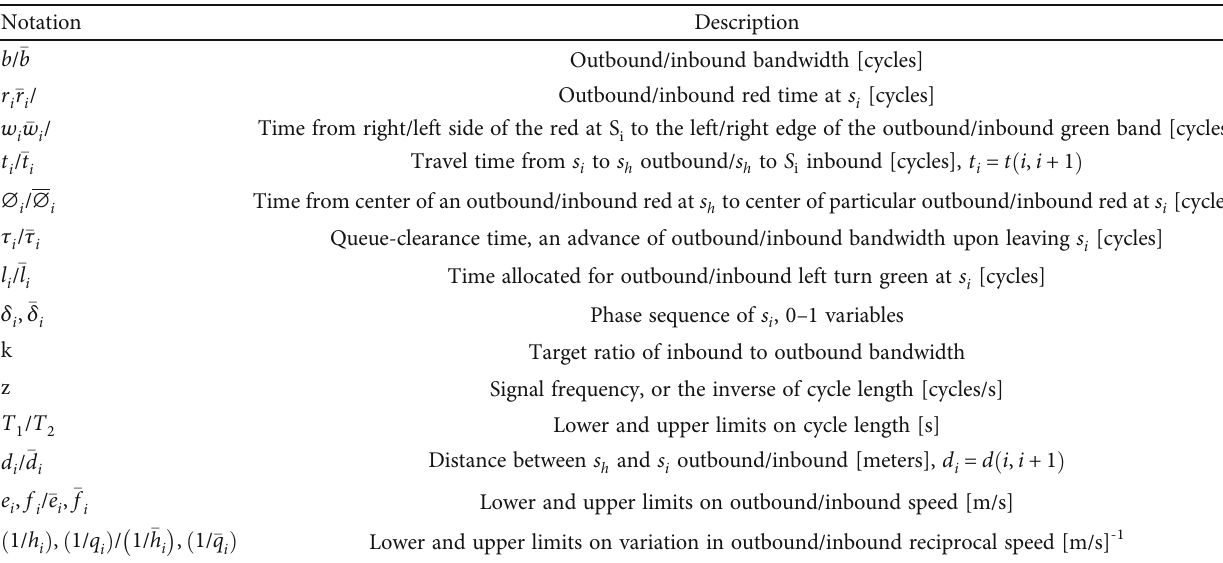
Table 1: Symbols and